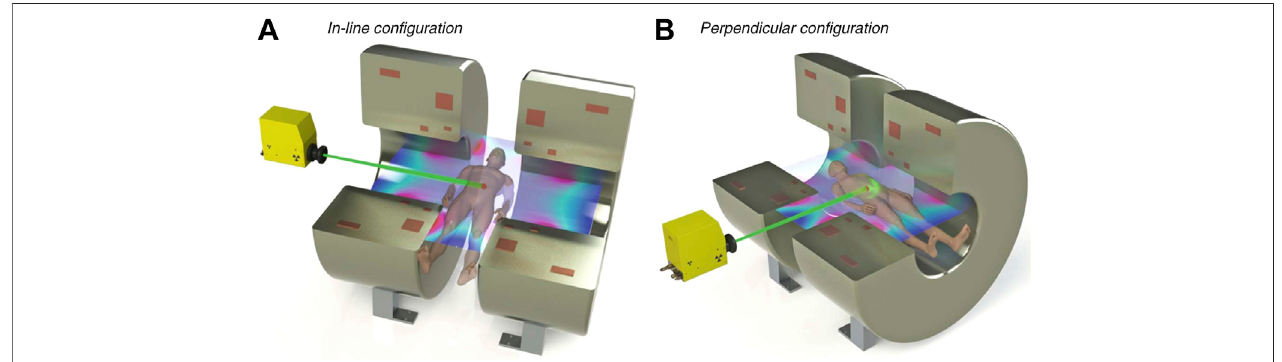
FIGURE1| DiagramshowingtheMRI-LINACorientations.In (A) ,thein-lineorientationisshown;in (B) ,theperpendicularorientationisshown.Figureadaptedfrom MRI for radiotherapy by Whelan et al. [41].